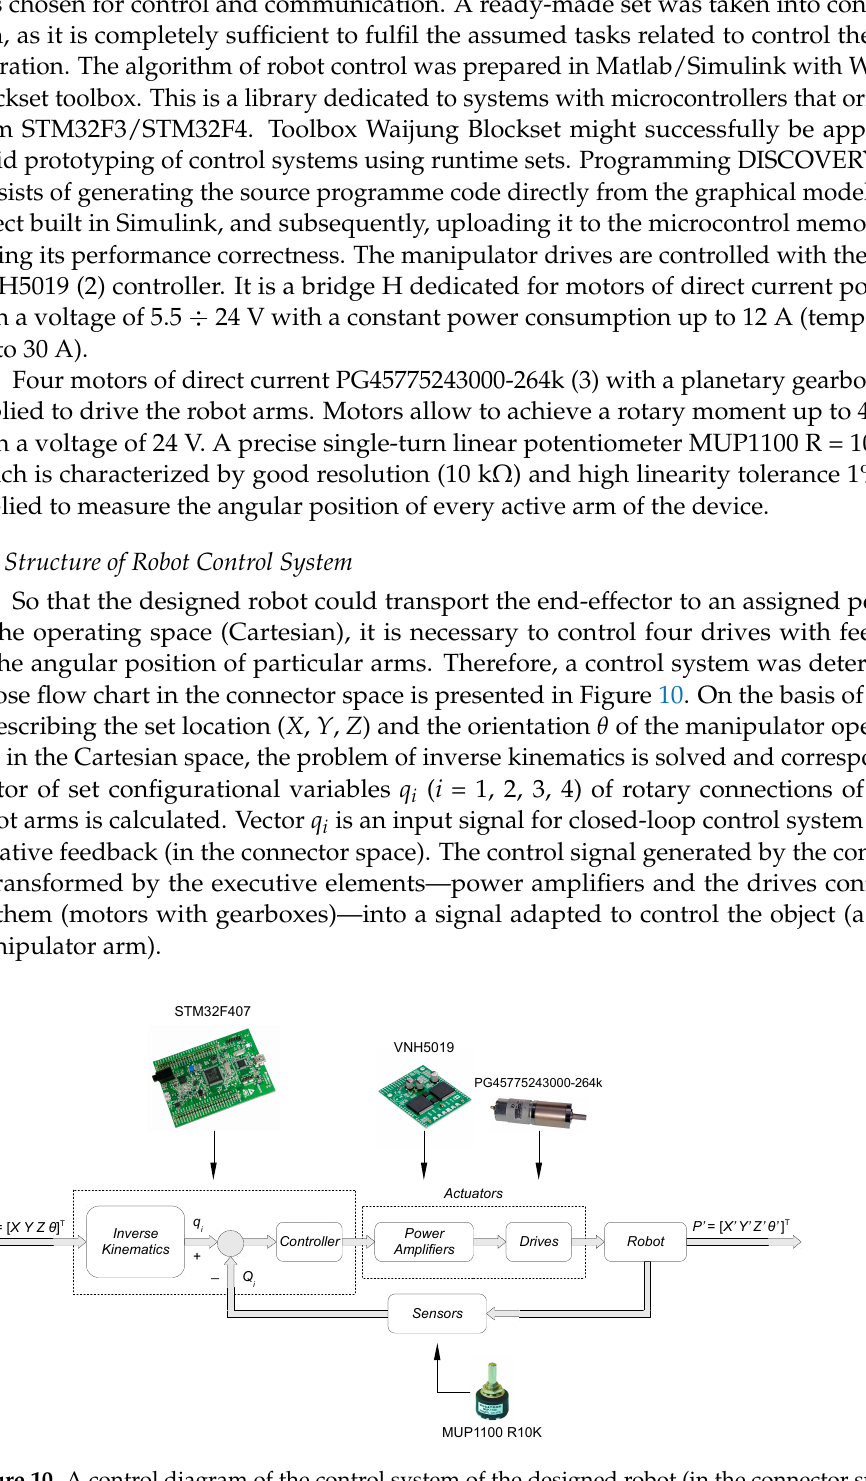
Figure 11. A diagram of the process of object identification. u ( t )—input signal; y ( t )—object response; y M ( t )—response of the object model; e ( t ) = y ( t ) − y M ( t )—identification error; ( ) ( )  =Θ T dtteJ 0 2 —quality indicator of compatibility of model and object; Θ i Θ *—respectively, model and real object parame- ters. For the purpose of this experiment, the measurement of the input u ( t )and output sig- nal y ( t ) of the object was conducted. The input signal was the voltage with the scope of – 12 ÷ 12 V, but the response of the object was the angular position (in degrees) of the output shaft of the motor gearbox. The mathematical model of the object was assumed in the form of a transfer function of the inertial element of the second row: ( ) 2 1 2 K G s s ∫ e 2 ( t ) dt Optimization Algorithm